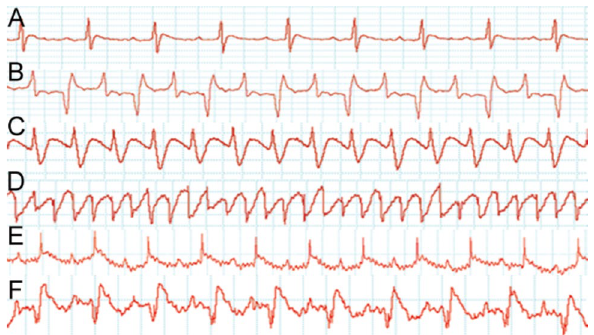
Figure 1. Electrocardiogram (ECG) tracings of rats in acute IHD models. The vertical axis of each ECG indicates voltage (mV), with 0.5 mV for all grids. The horizontal axis of each ECG indicates time (s), with 0.2 s for all four grids. (A) Normal rat ECG tracing. (B–D) ECG tracings of rats with ventricular arrhythmias (VAs) induced by BaCl 2 solution: (B) supraventricular tachycardia (SVT), (C) ventricular tachycardia (VT), and (D) ventricular fibrillation (VF). (E) The ST segment elevation in rats after coronary artery ligation (CAL). (F) The ST segment elevation and pathological Q wave were shown in ECG tracings after continuous injection of isoproterenol (ISO) solution for 2 consecutive